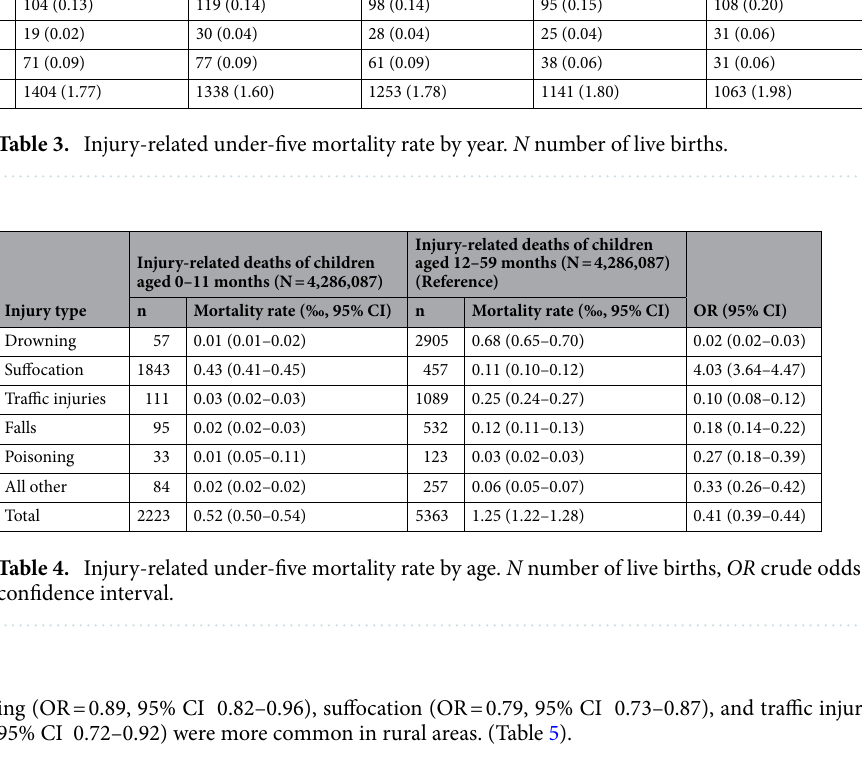
Table 7 showed the following epidemiological characteristics of injury-related deaths: (1) The number of injury-related deaths decreased with children’s age. (2) Injury-related deaths happened more frequently in